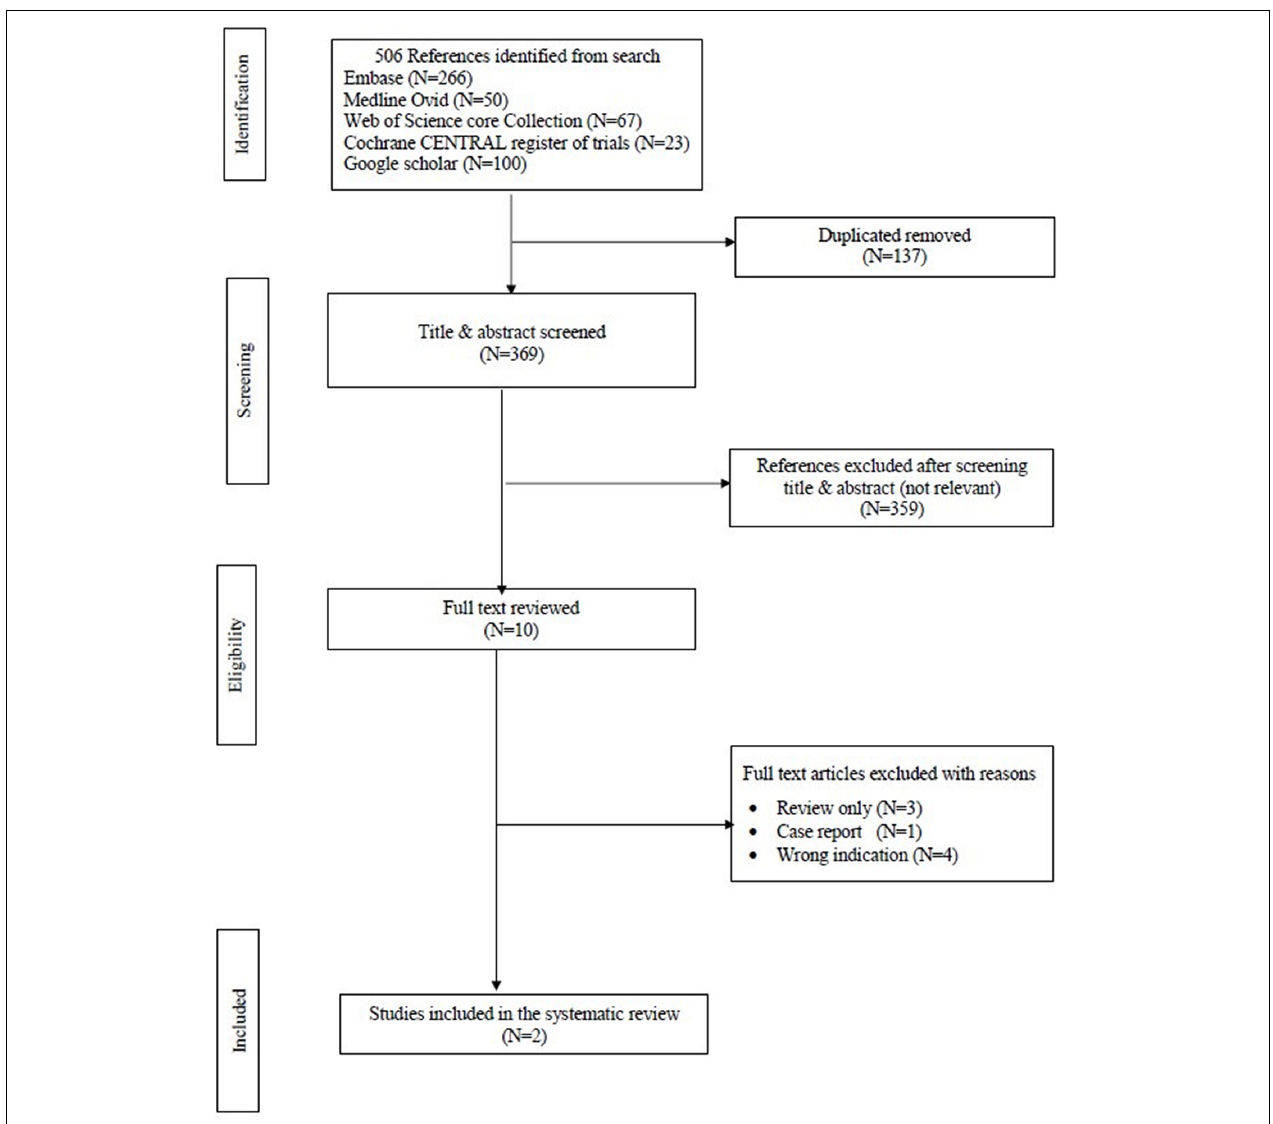
FIGURE 1 | Preferred reporting items for systematic reviews and meta-analyses (PRISMA) flow chart of the